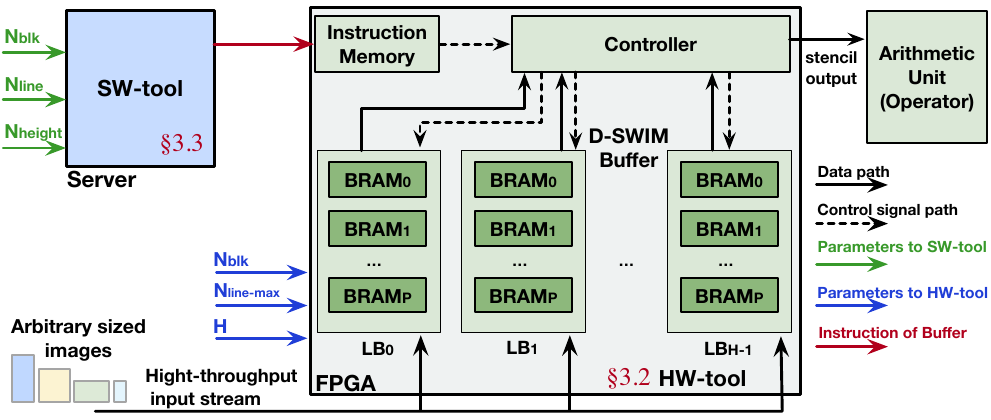
Figure 4. Overview of D-SWIM framework.